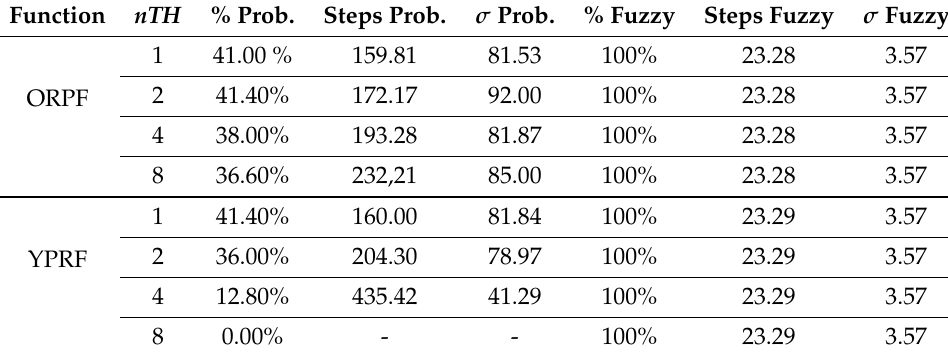
Table 1. Steps required to converge for probabilistic/possibilistic Markov chains with random environments.